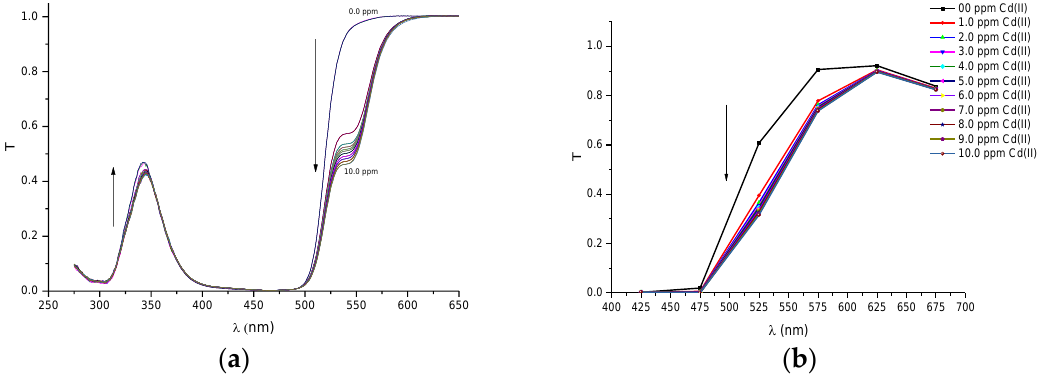
Figure A2. The transmittance spectra of the chromogen reagent of 1-(2-pyridylazo)-2-naphthol (PAN) solution containing Cd(II) ions at different concentrations corresponding to: ( a ) The UV-VIS Cary ® 50-Varian spectrometer ( b ) the multiespectral MMCS6CS sensor.